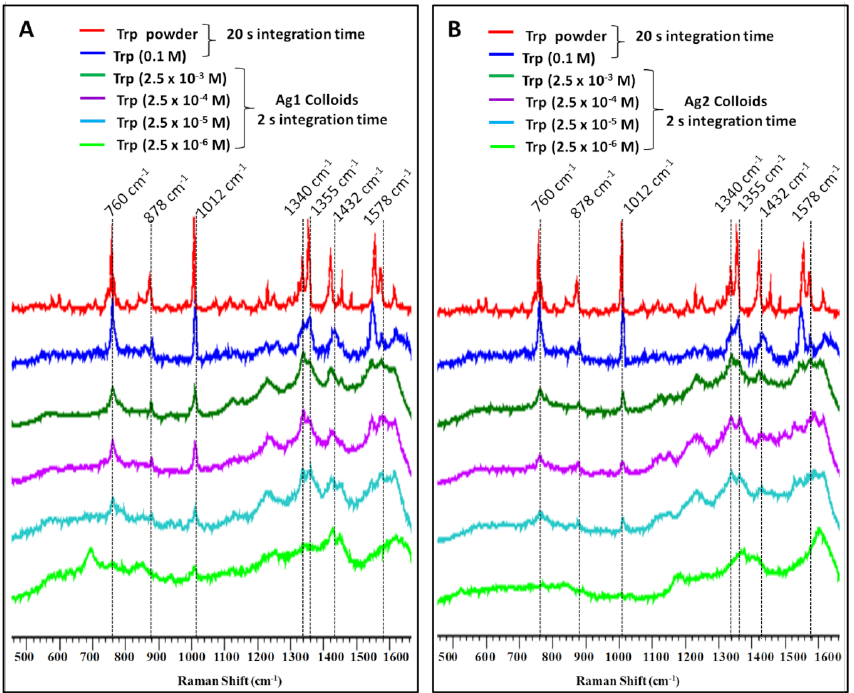
Figure 3. Surface-enhanced Raman spectra of Tryptophan at indicated concentrations using ( A ) sodium citrate (Ag1) and ( B ) sodium borohydride (Ag2) reduced silver nanoparticles activated with acidic KCl solution and compared with the spectrum of pure Trp powder and 0.1 M aqueous solution.